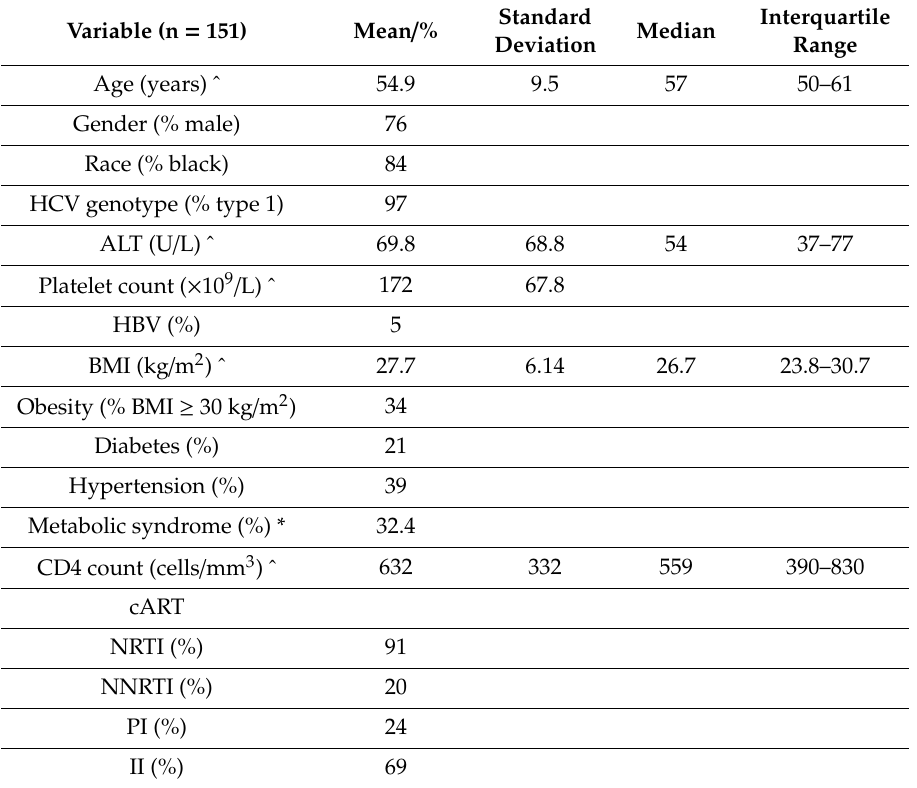
Table 1. Demographic and laboratory characteristics of the